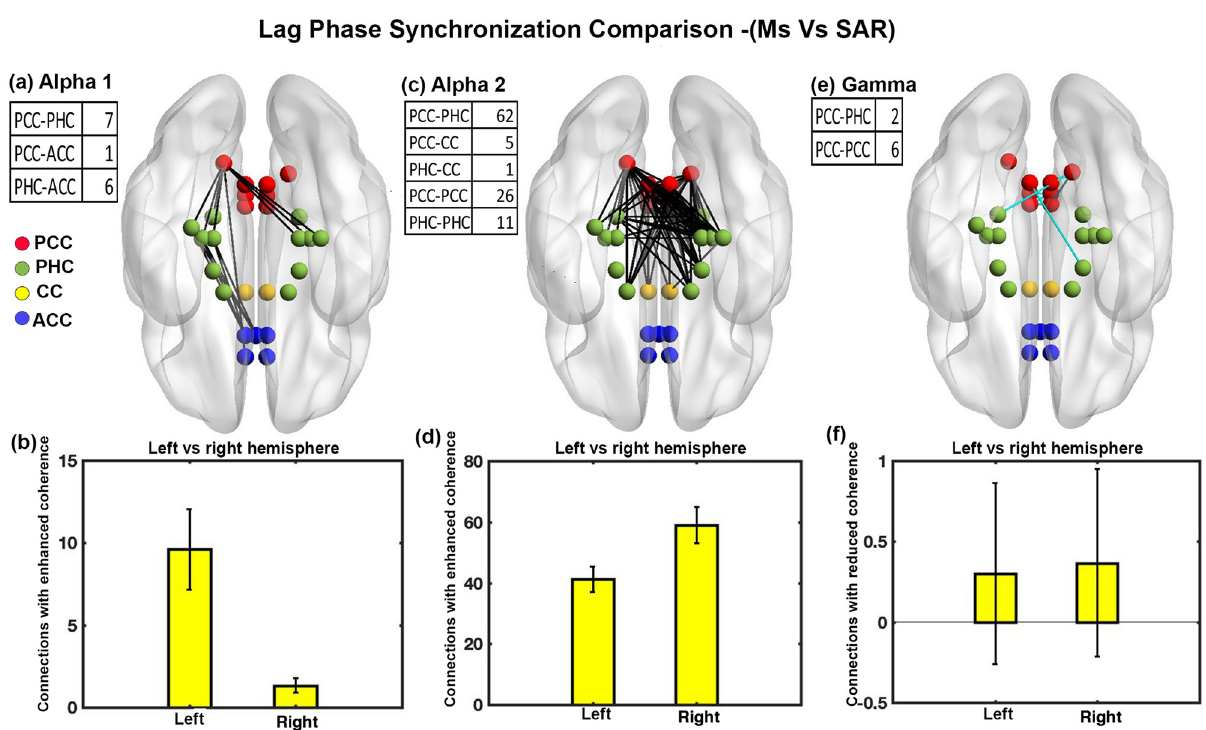
Fig 1. Phase coherence comparison between sad music condition and SAR. (a) Brain’s connections (14) with a significant increase in the lag phase synchronization in alpha1 band, (b) Brain hemisphere lateralization with respect to inter-connections with increased coherence in alpha1 band,(c) Brain’s connections (105) with a significant increase in the lag phase synchronization value in alpha2 band. (d) Brain hemisphere lateralization with respect to inter-connections with increased coherence in alpha2 band, (e) Brain’s connections (8) with a significant decrease in the lag phase synchronization value in the gamma band (f) Brain hemisphere lateralization with respect to inter-connections with decrease coherence in gamma band (error bars = 1 SD).